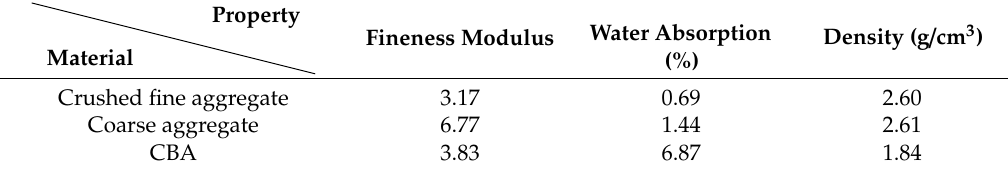
Figure 3. SEM image of CBA aggregate.